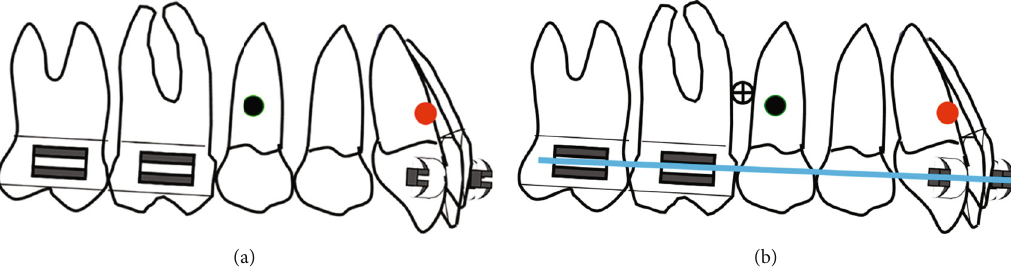
Figure 1: (a) Typical strap up ( 0 : 022 ” × 0 : 028 ” slot), maxillary arch is bonded bypassing the premolars; black circle is the center of resistance of the whole arch; red circle is the center of resistance of the anterior segment. (b) After leveling and alignment, a 0 : 017 ” × 0 : 025 ” stainless steel archwire is inserted and a microimplant (cross circle) is placed bilaterally between the second premolar and the fi rst molar.